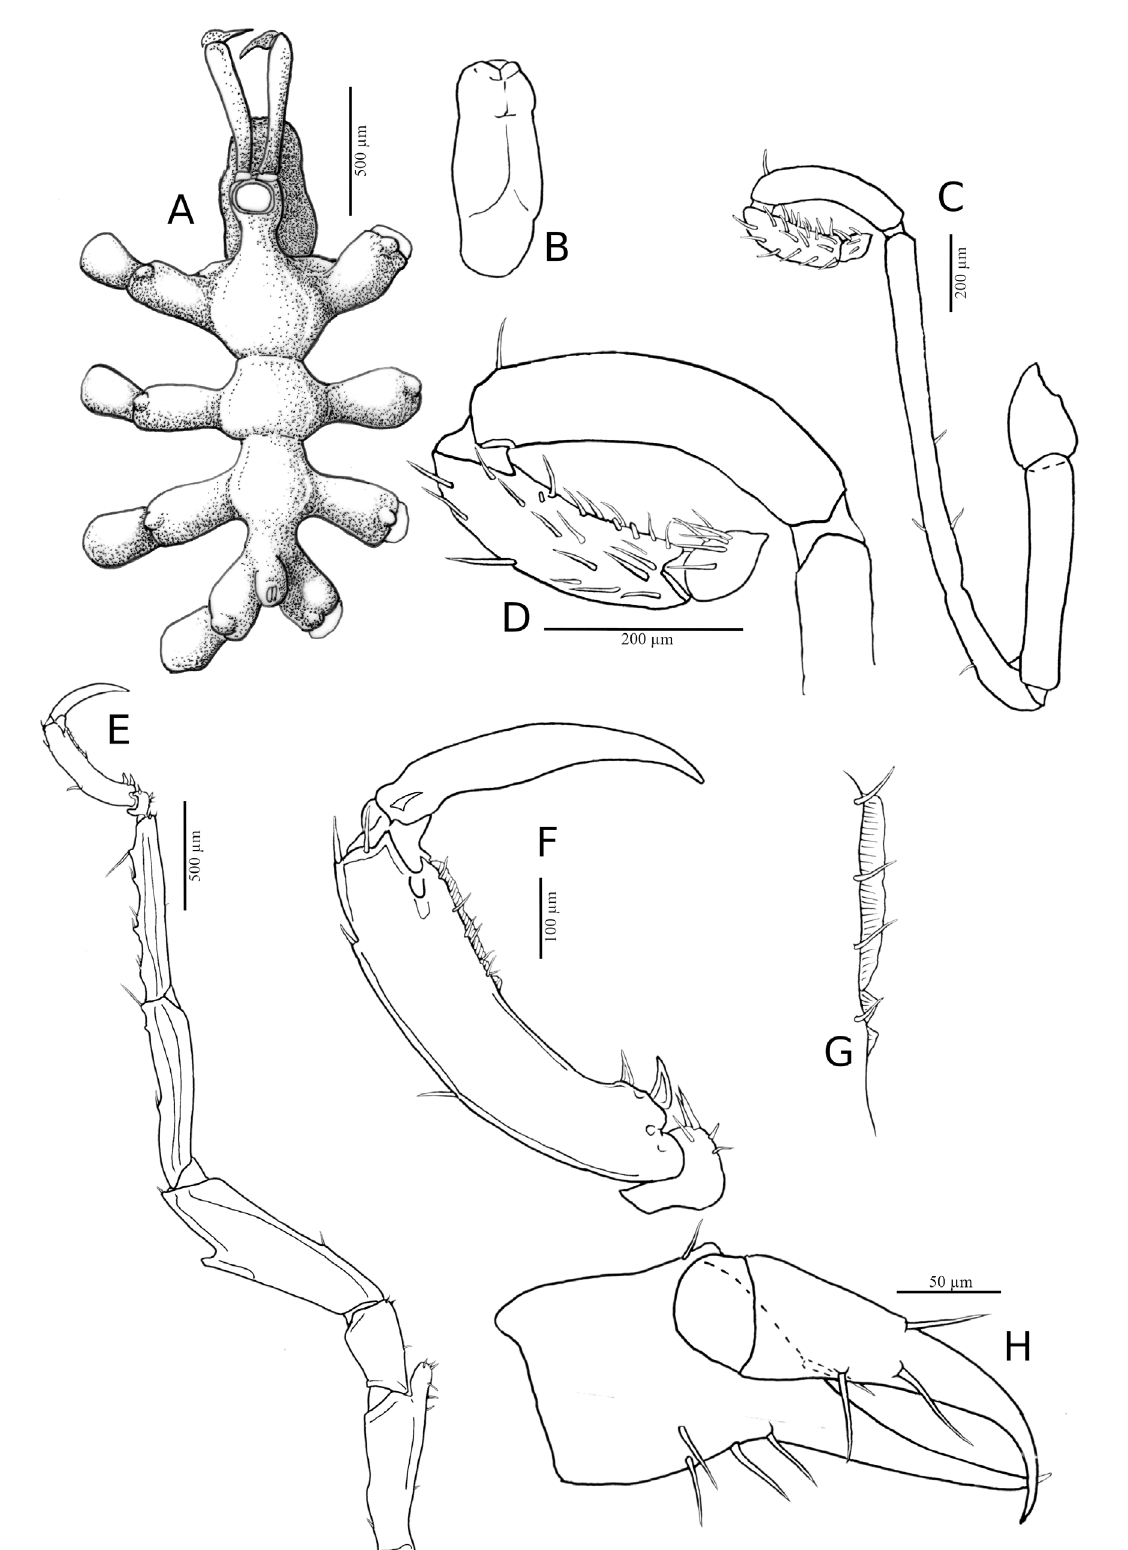
Fig. 26. Anoplodactylus sp. 7, ♂, MNHN-IU-2016-1163. A . Body, dorsal view. B . Proboscis in ventral view (same scale as A). C . Oviger. D . Oviger terminal articles. E . Fourth leg. F . Tarsus and propodus of fourth leg. G . Propodal sole lamina. H .